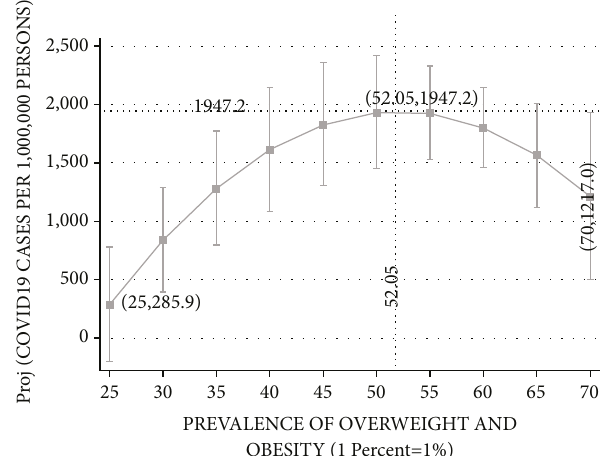
Figure 3: COVID-19 cases per 10,00,000 persons vs. prevalence of overweight and obesity. The vertical axis measures the projected probability of COVID-19 cases per 10,00,000 persons based on the formula: 1 , 000 , 000 ( COVID19 CASES ÷ POPULATION ) applied separately to 23 OECD countries. The horizontal axis measures the frequency of overweight and obesity (BMI ≥ 25 where BMI � kg/meter 2 ) in the population of OECD countries based on measured height and weight. The figure is based on the following regression outcomes given in column